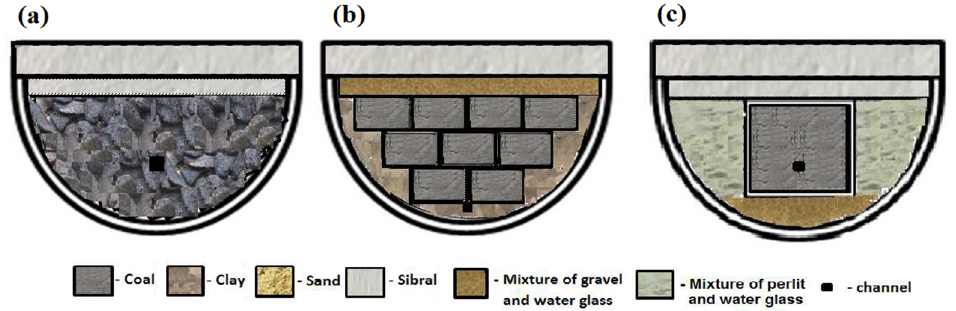
Figure 3. Physical coal seam model for the ( a ) experiment #1, ( b ) experiment #2, ( c ) experiments #3 and #4. Table 1. The analysis of the input and unburned